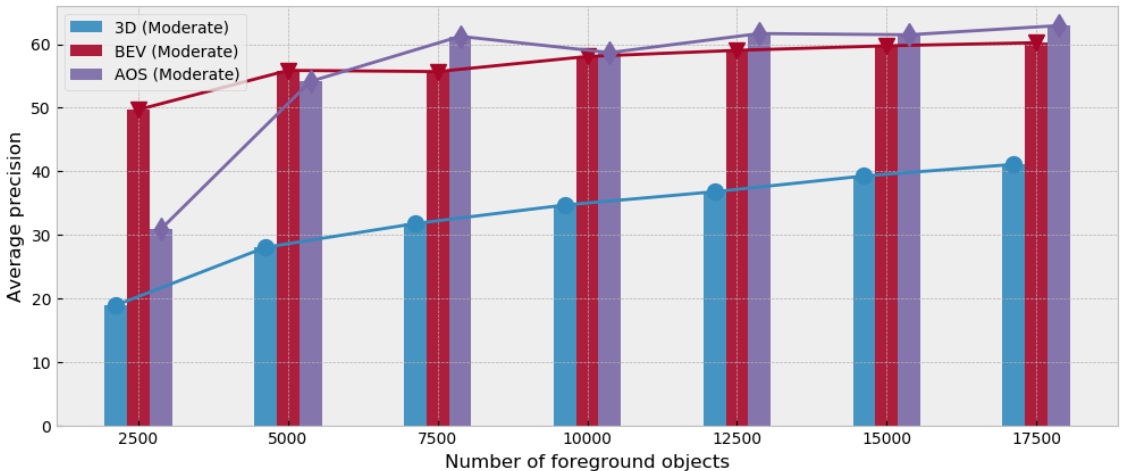
Figure 10. The influence of the number of foreground objects in the hybrid dataset on the average precision of the 3D